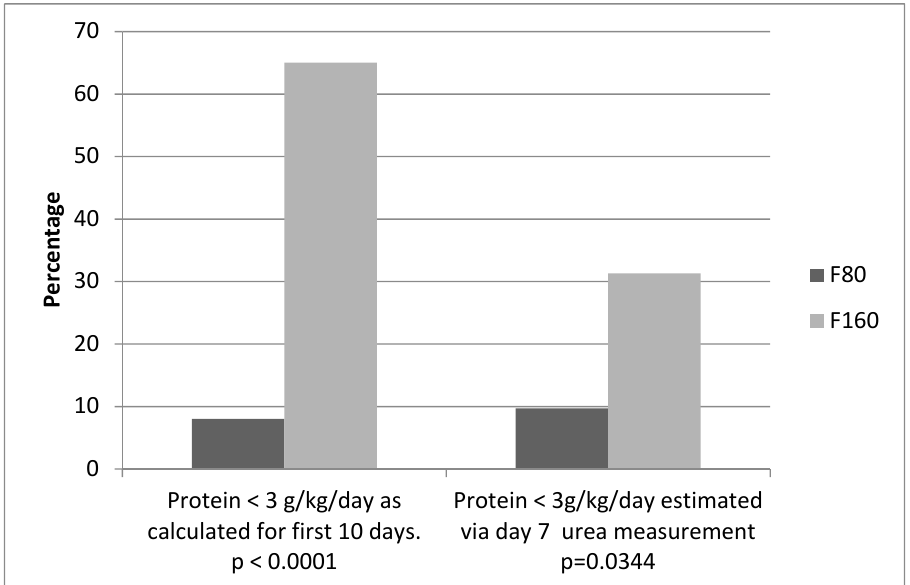
Figure 2. Frequency of infants with protein intake <3 g/kg/day calculated versus estimated via blood urea measurement. χ 2 test for probability.